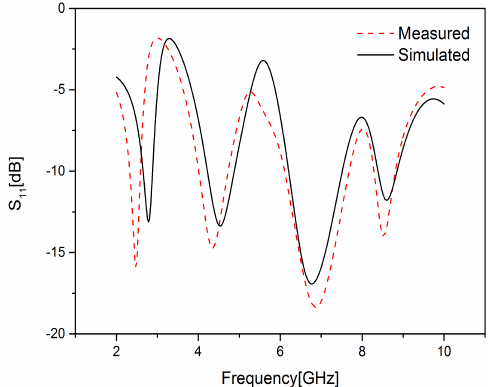
Figure 9. Simulated and measured results of the return loss of the proposed antenna.